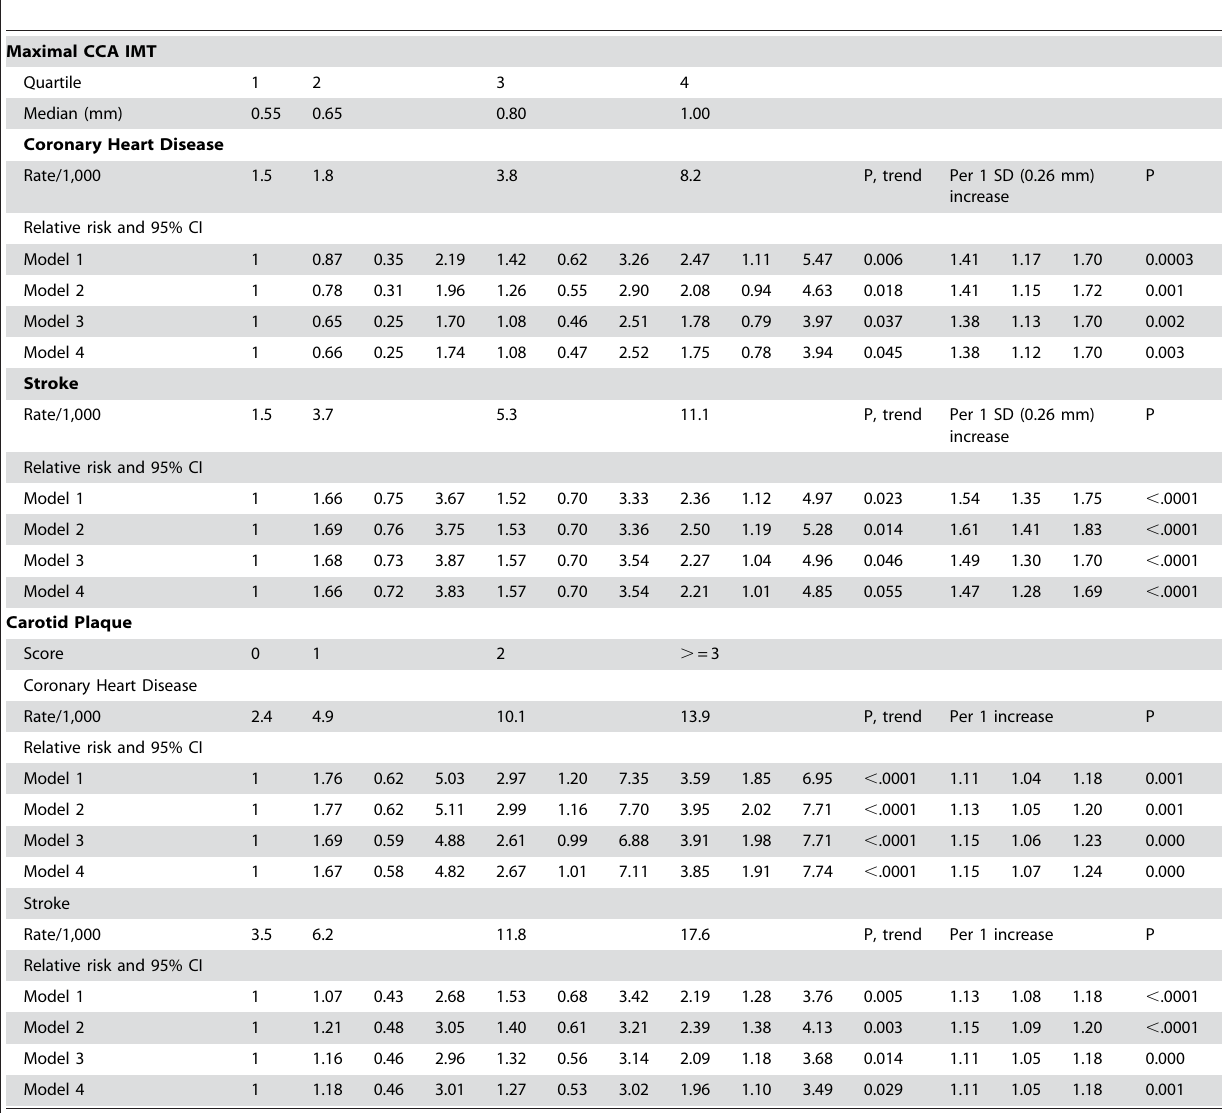
Table 3. Median level, incident rates, relative risks and 95% confidence intervals of coronary heart disease and stroke in the study participants according to maximal CCA IMT quartile and carotid